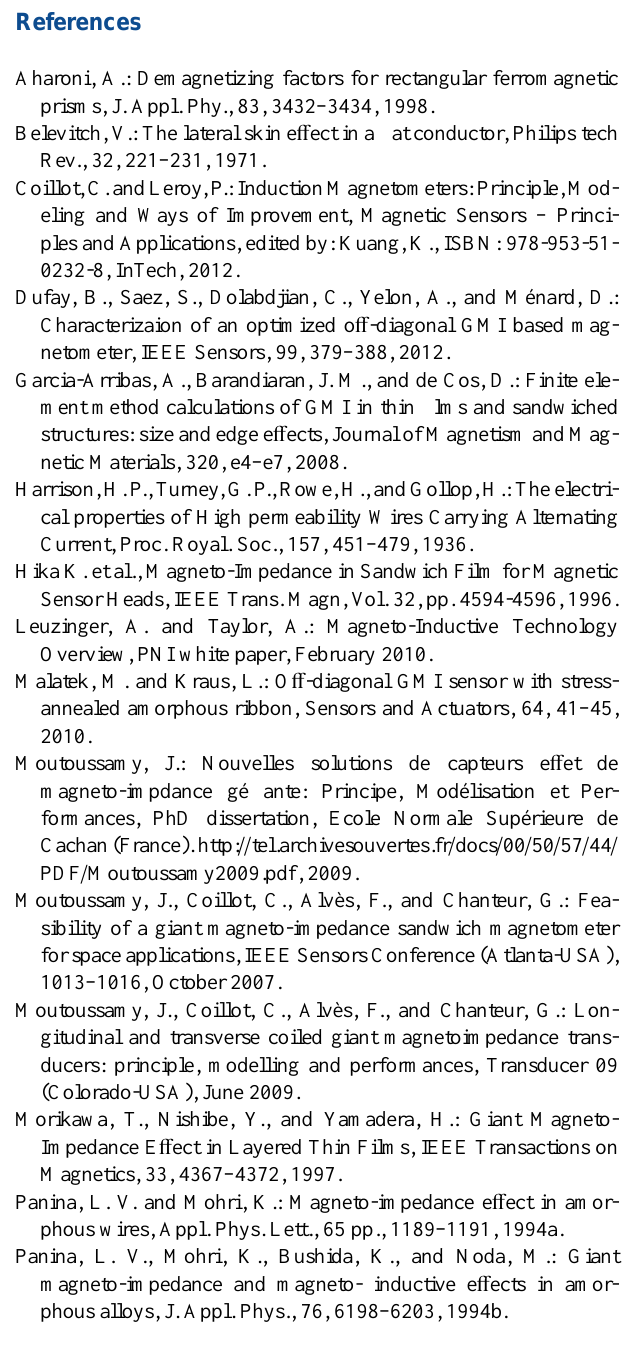
Figure 11. The launch of the CHARM-II rocket from Poker Flat (Alaska) during an aurora borealis (Copyright Micah P. Dom- browski)